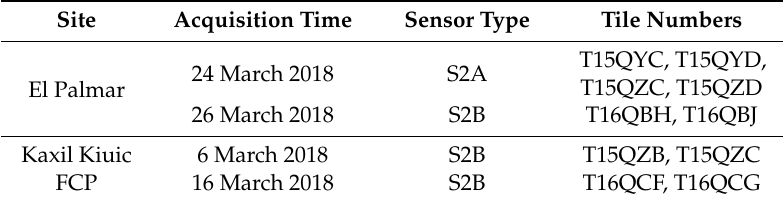
Table 1. Sentinel 2 multi spectral instrument images used in this